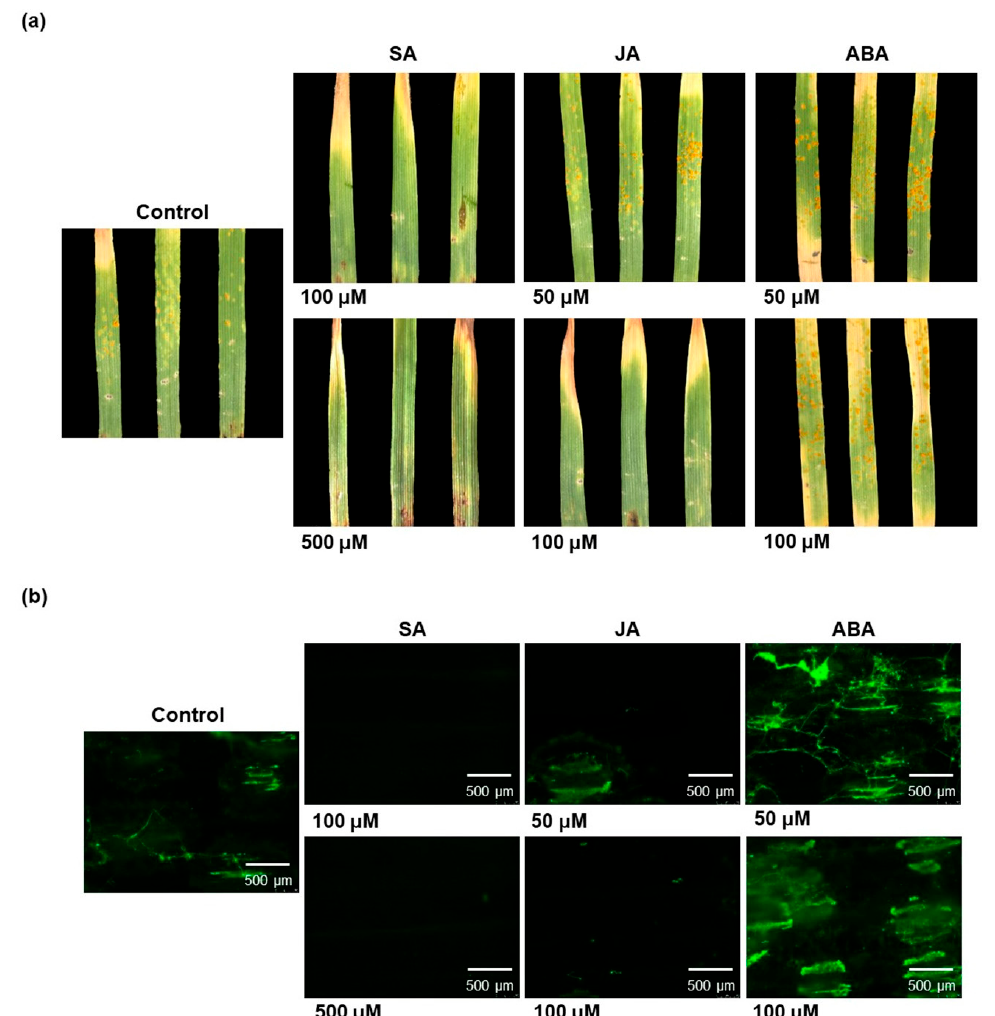
Figure 3. Effect of salicylic acid (SA), jasmonic acid (JA), and abscisic acid (ABA) on Keumkang wheat leaf rust resistance. ( a ) Morphologies and ( b ) fluorescence microscopy images were compared among the detached Keumkang wheat leaves of 14-days-old seedlings grown on the BAP media containing SA, JA, or ABA for 10 days after inoculation with leaf rust. The evaluation was done by staining with a lectin from Triticum vulgaris